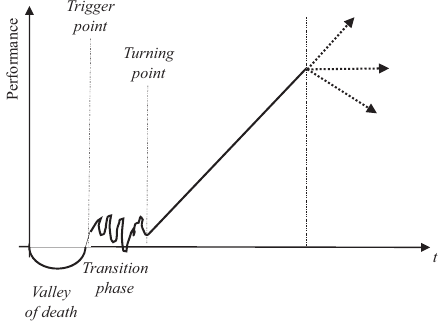
Figure 2. Generic trajectory